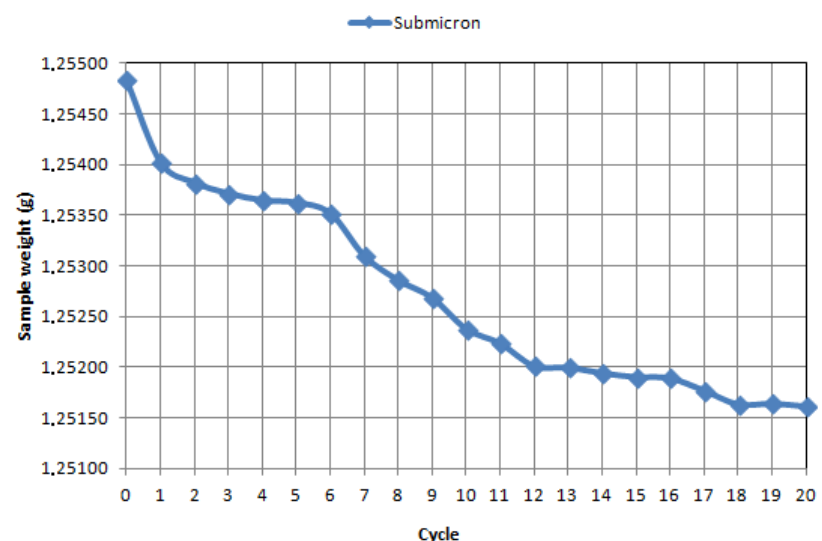
Figure 7. Loss of mass during tribological tests after 20 cycles for sintered micro-powder at 5 N load.